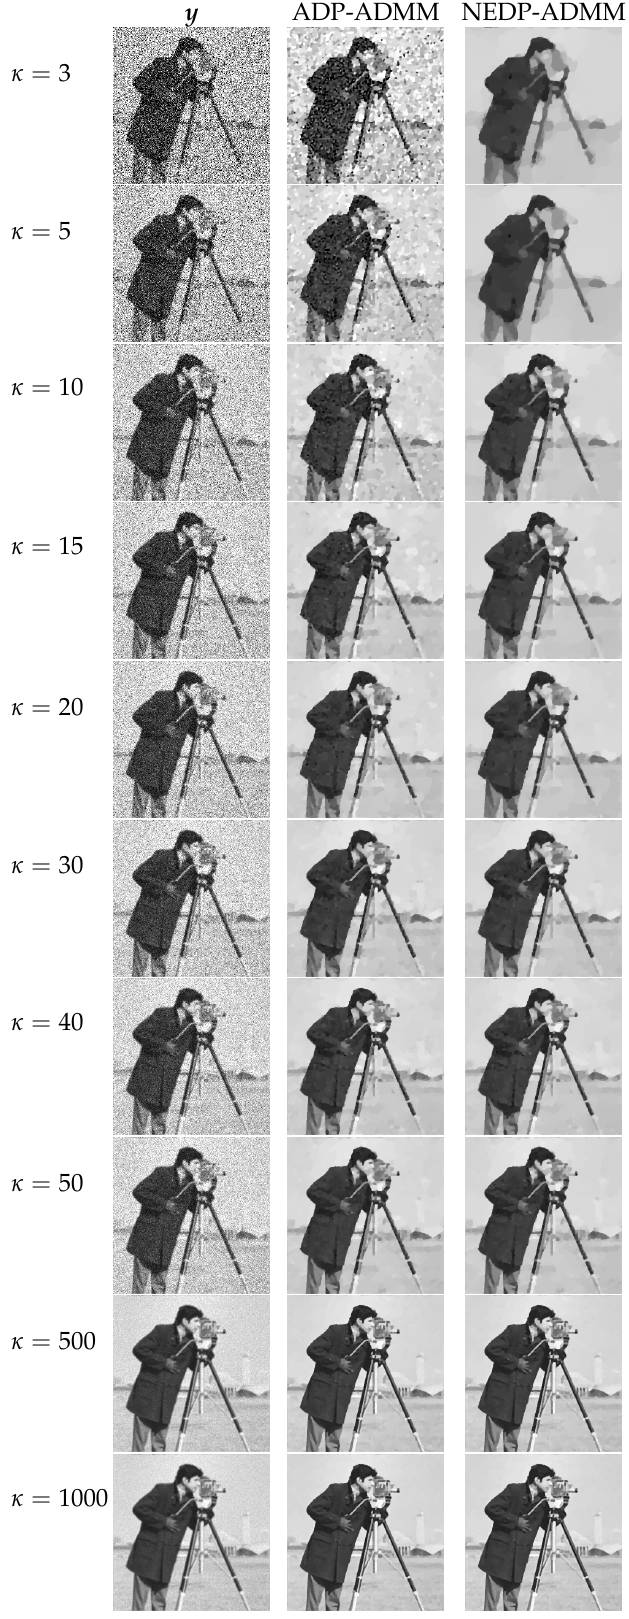
Figure 7. Test image cameraman . Left column: observed data y corrupted by Gaussian blur with parameters band = 5, sigma = 1 and Poisson noise with different κ -values ranging from 3 to 1000. Middle column: restorations by ADP-ADMM. Right column: restorations by